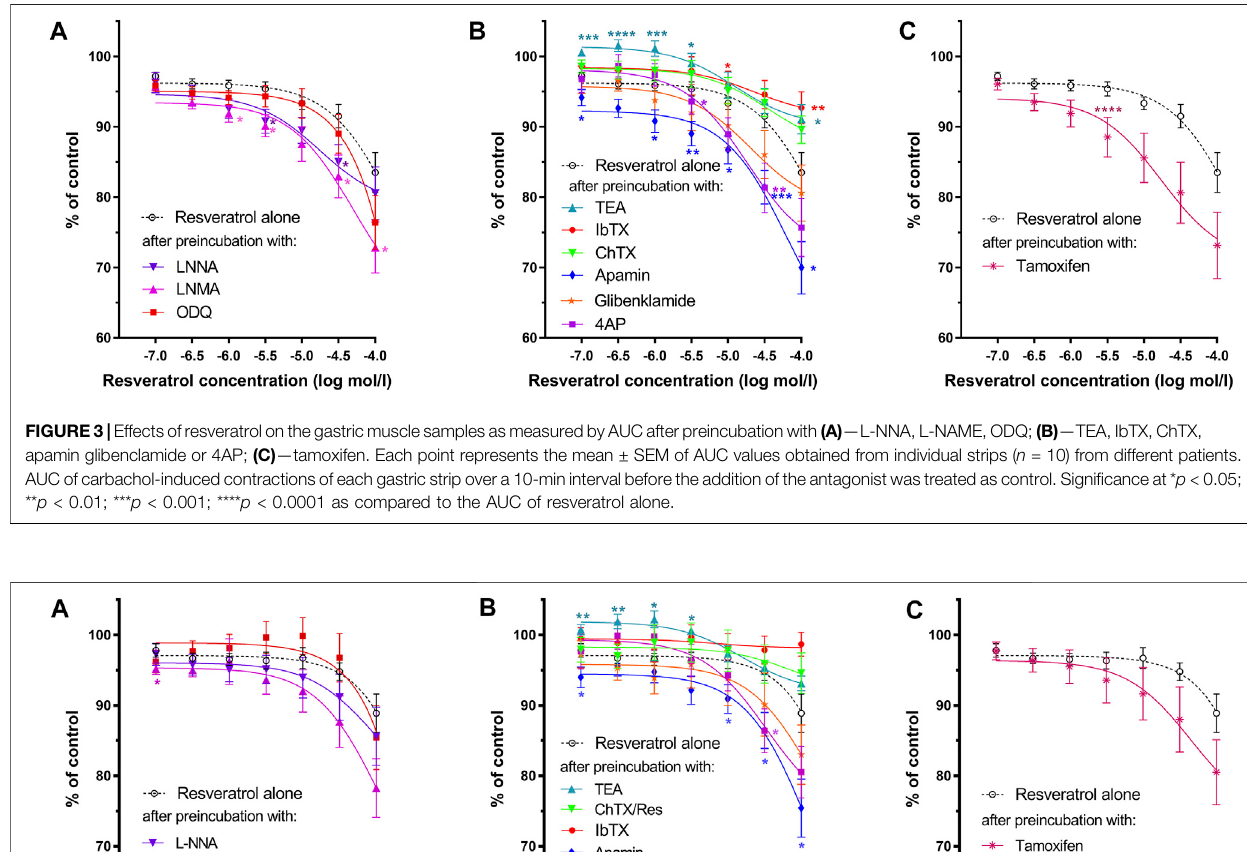
Frontiers in Pharmacology |